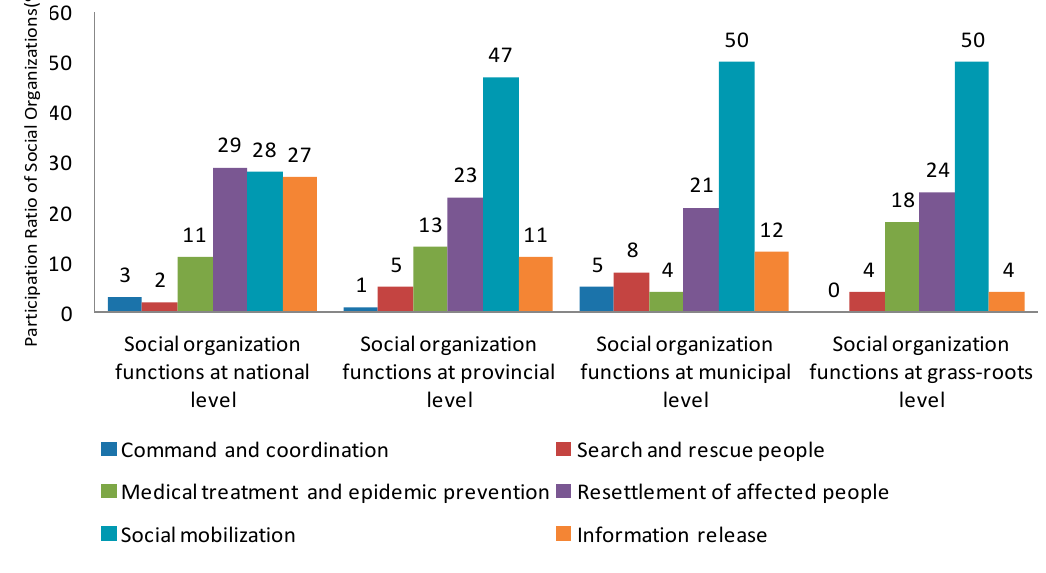
Figure 7. Main functions of social organization at different levels.